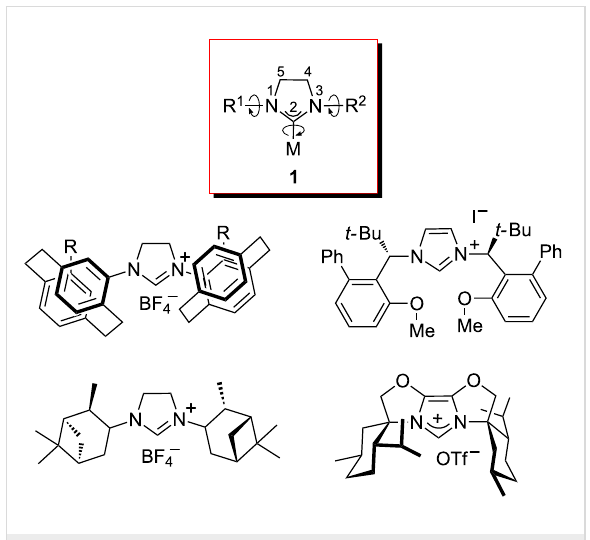
Figure 1: Monodentate NHCs with sterically hindered